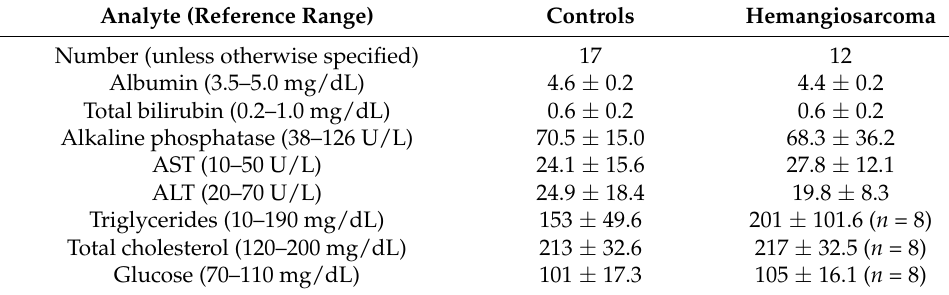
Table 2. Routine Clinical